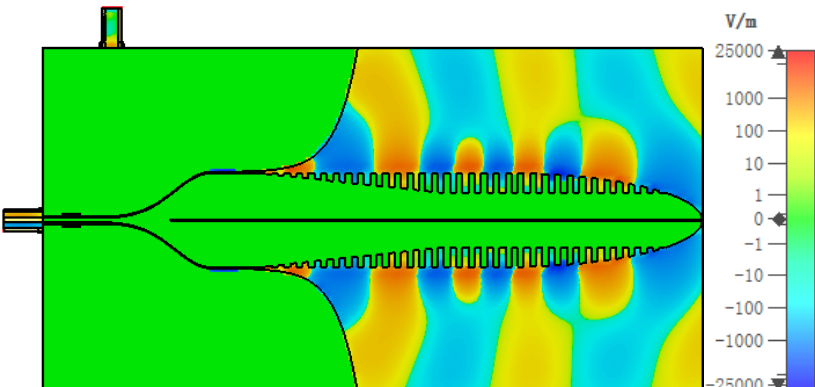
Figure 8. Field distribution of antenna when d = 4 mm at 10 GHz.